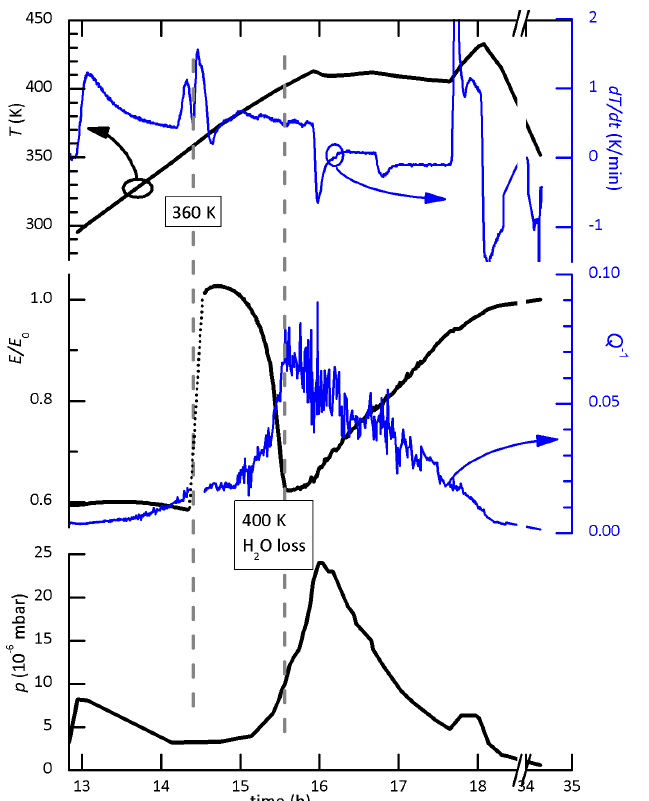
Figure 3. Time dependence of the Young’s modulus E / E 0 and Q − 1 of FAPI #6, together with its temperature T , dT / dt and pressure under continuous pumping. The pressure around the sample might be an order of magnitude higher than that measured in the vacuum